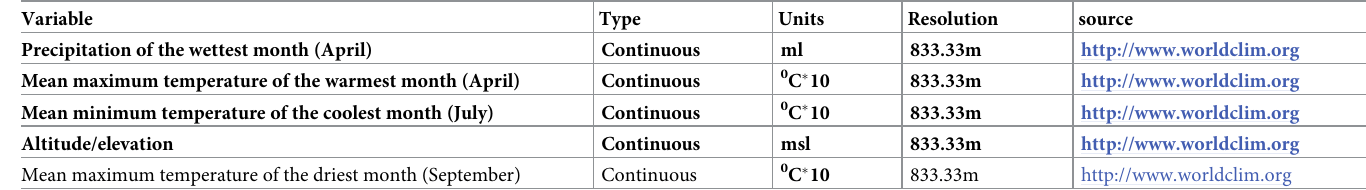
Table 1. Candidate covariates tested used in initial model runs, and the bolded ones used in the best-performing MaxEnt